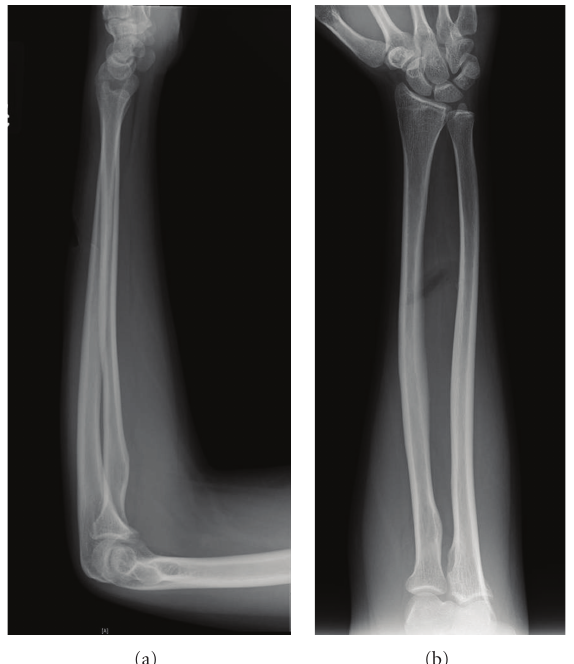
Figure 3: Initial (a) anteroposterior and (b) lateral films of 18-year-old right hand dominant male who sustained machete laceration to his left dorsal